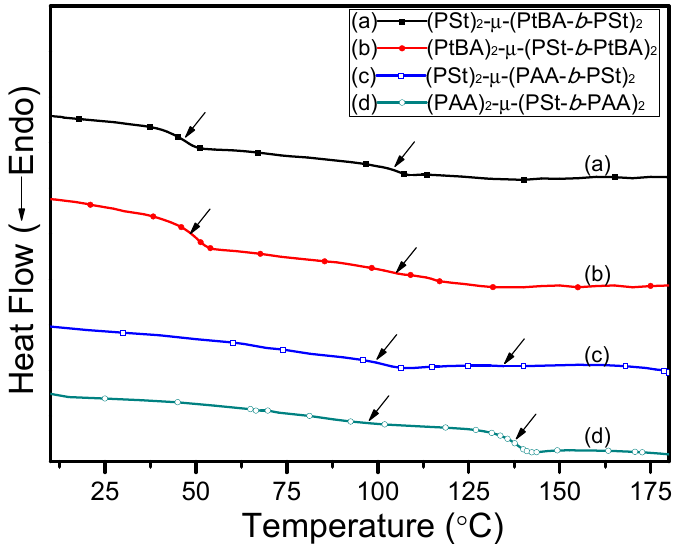
Figure 7. DSC traces of ( a ) (PSt) 2 - µ -(PtBA- b -PSt) 2 , ( b ) (PtBA) 2 - µ -(PSt- b -PtBA) 2 , ( c ) (PSt) 2 - µ -(PAA- b - PSt) 2 , and ( d ) (PAA) 2 - µ -(PSt- b -PAA) 2 µ -stars.